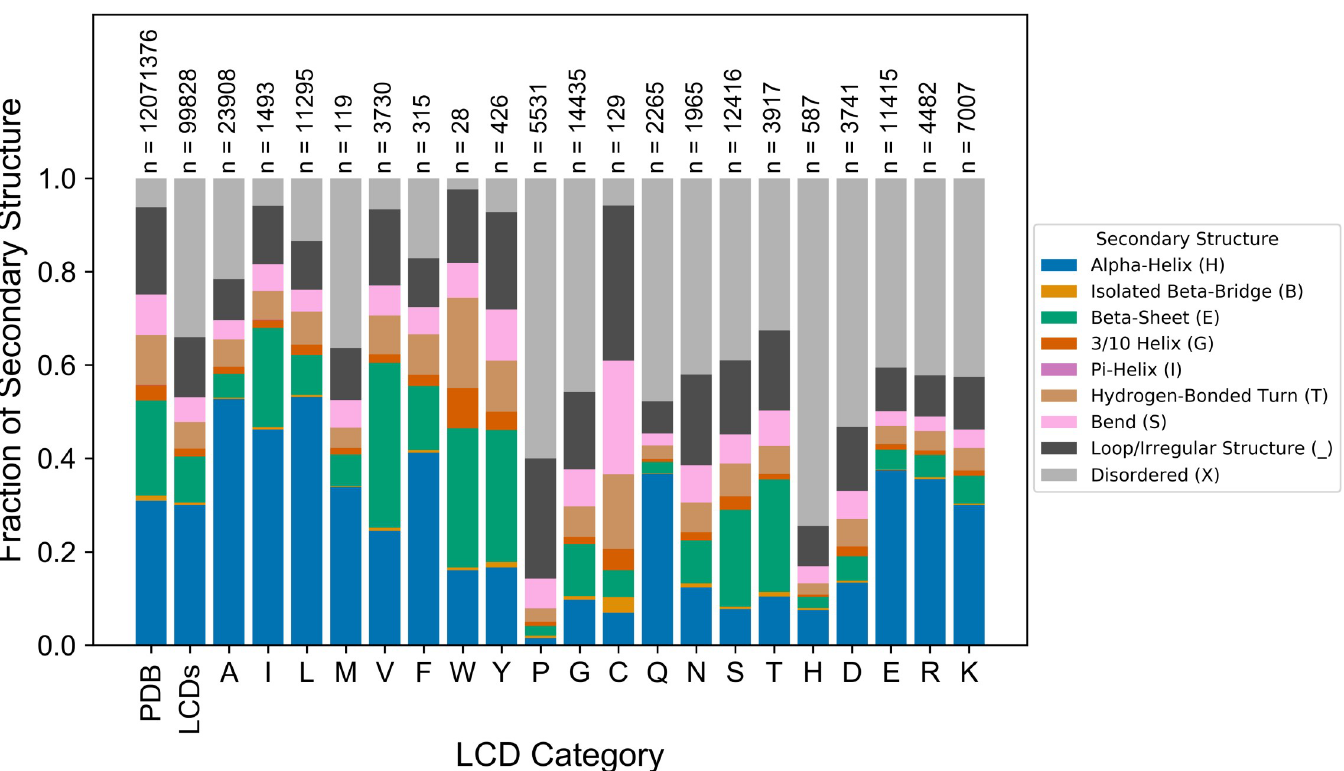
Fig 5. LCD classes parsed by predominant amino acid exhibit unique structural tendency profiles. LCDs with Shannon entropy � 2.2 bits were parsed into amino acid categories based on the most frequent amino acid within each peptide subsequence. Bars indicate the mean fraction of each secondary structure type for all subsequences within each amino acid-specific LCD bin. For comparison, the mean fraction of each type of secondary structure for all subsequences across all proteins (“PDB” group) and for all peptides qualifying as LCDs combined into a single category (“LCDs” group) are also